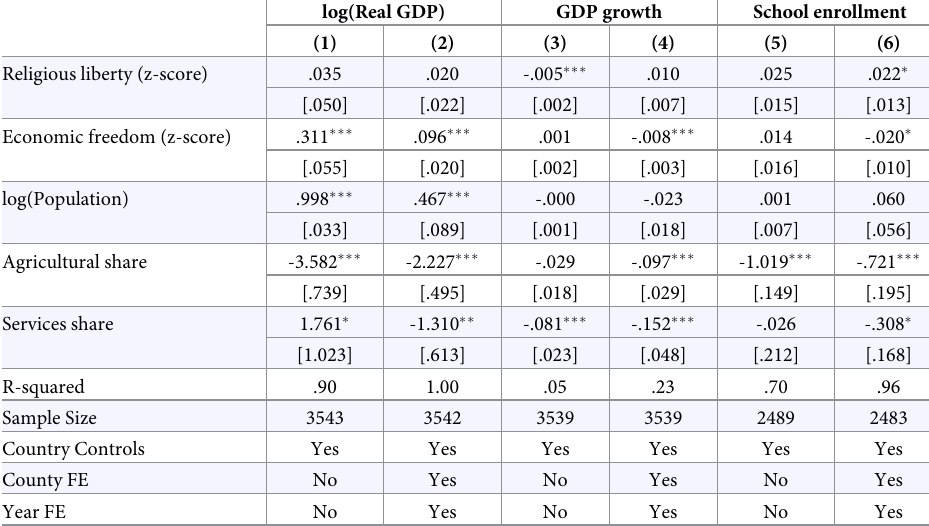
Table 5. Examining the effects of religious liberty on economic development.